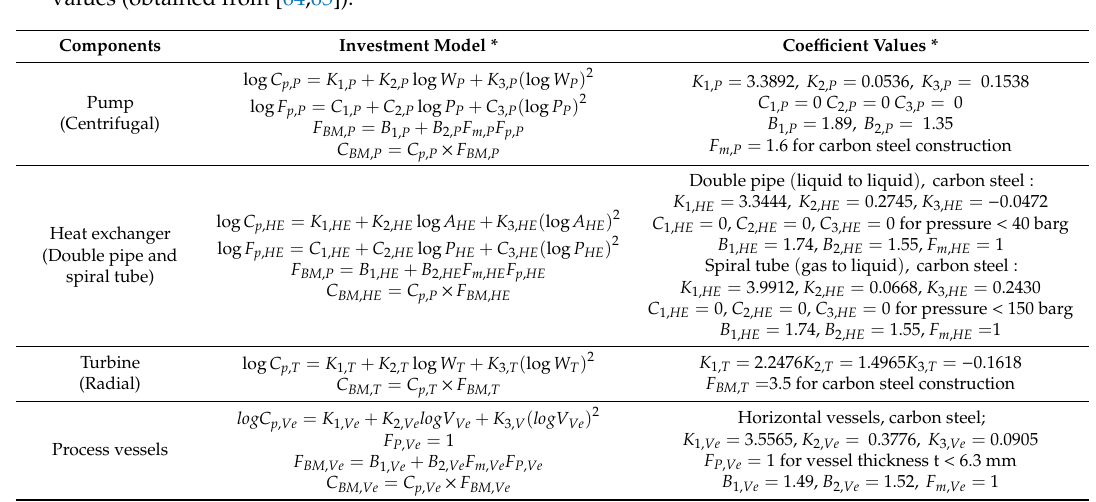
Table 5. Investment model of each component in waste heat recovery options and their coe ffi cient values (obtained from